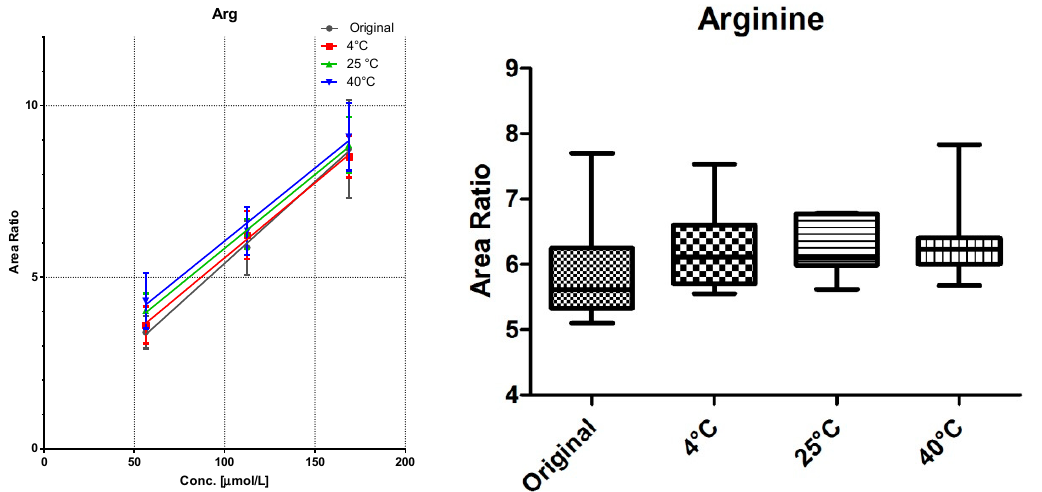
Figure 3. LC-MS/MS analysis of arginine from DBS cards stored at different storage temperatures: ( left ) linearity (mean ± sd of n = 7); and ( right ) box and whiskers graph of level 2 with 5–95 percentiles of the same data.